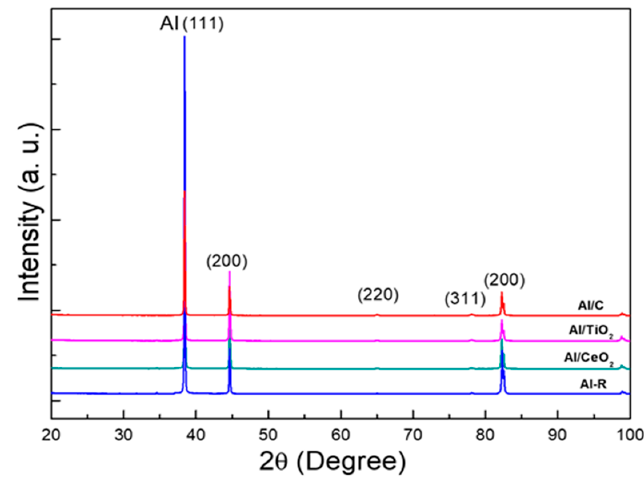
Figure 2. X-ray di ff raction patterns of composites after the extrusion process at 550 ◦ Figure 2. X-ray diffraction patterns of composites after the extrusion process at 550 °C.